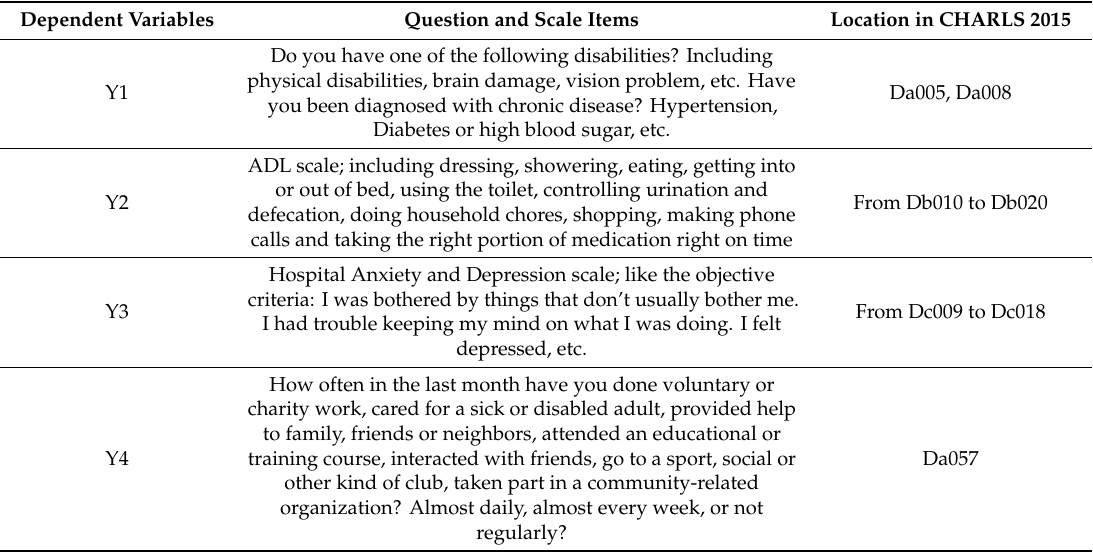
Table A1. Specific items of the scale related to dependent variables.